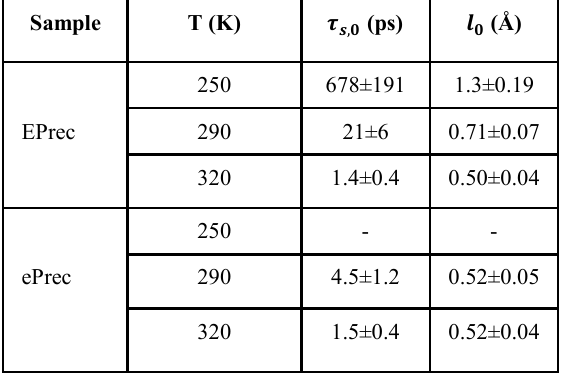
Table 1. Values of the parameters involved in the Anomalous Jump Diffusion (AJD) fitting the EPrec and ePrec results described with KWW